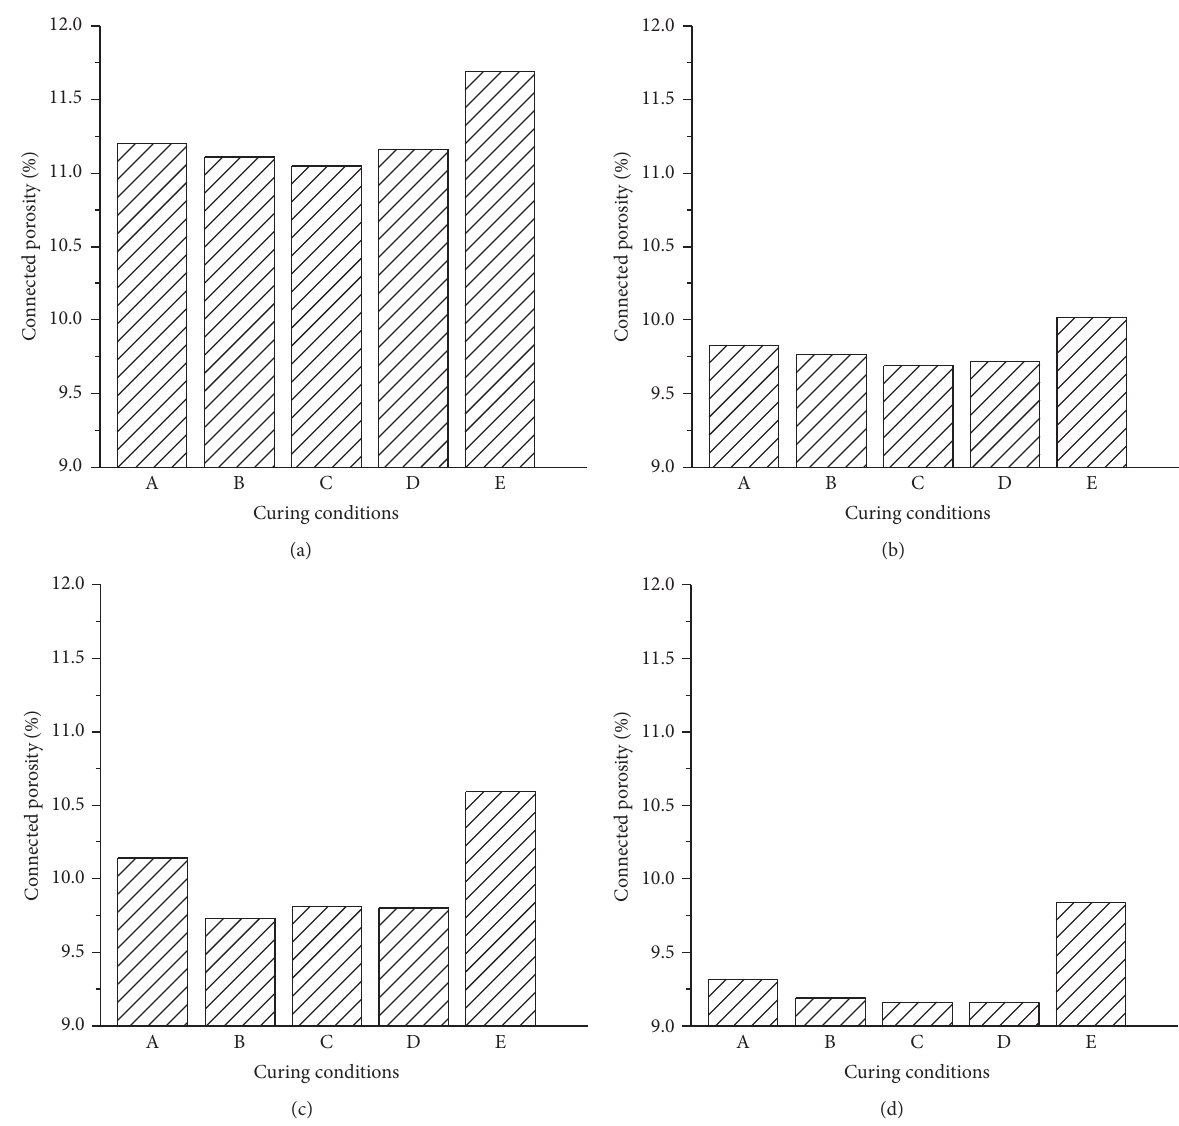
Figure 8: The connected porosity of concrete at the age of 360 days. Samples: (a) plain cement, (b) 45% FA, (c) 45% GGBS, and (d) 12%